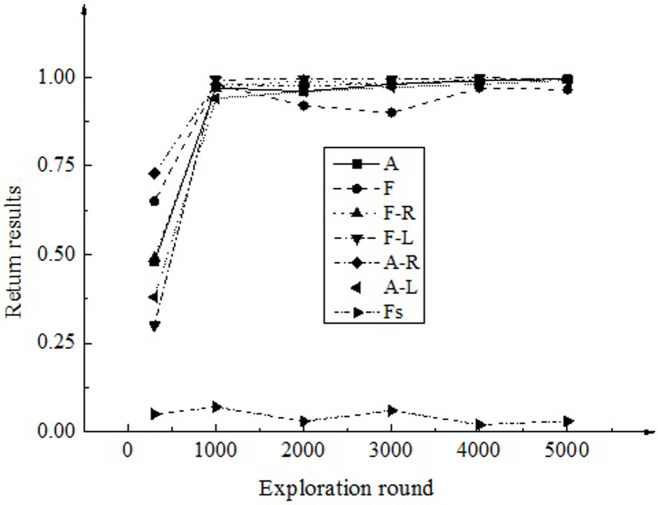
Performance test results of M-DDPG algorithm when adding an error task (Fs represents the error strategy).